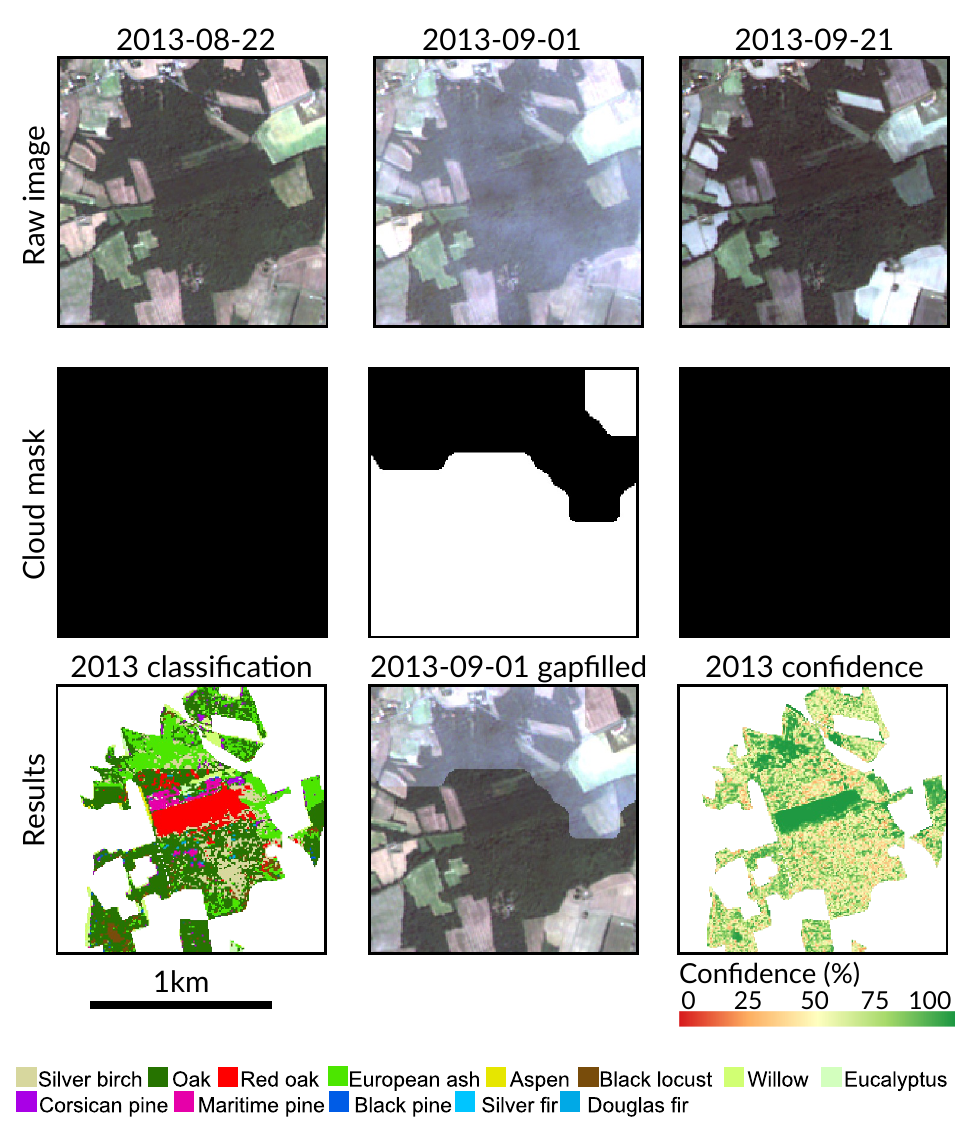
Figure A3. Example of misclassified forest stand (for European ash, in the north) due to under-detected clouds in 1 September 2019. In the cloud mask, pixels in black are cloud and shadow free. Pixels in white are cloudy or